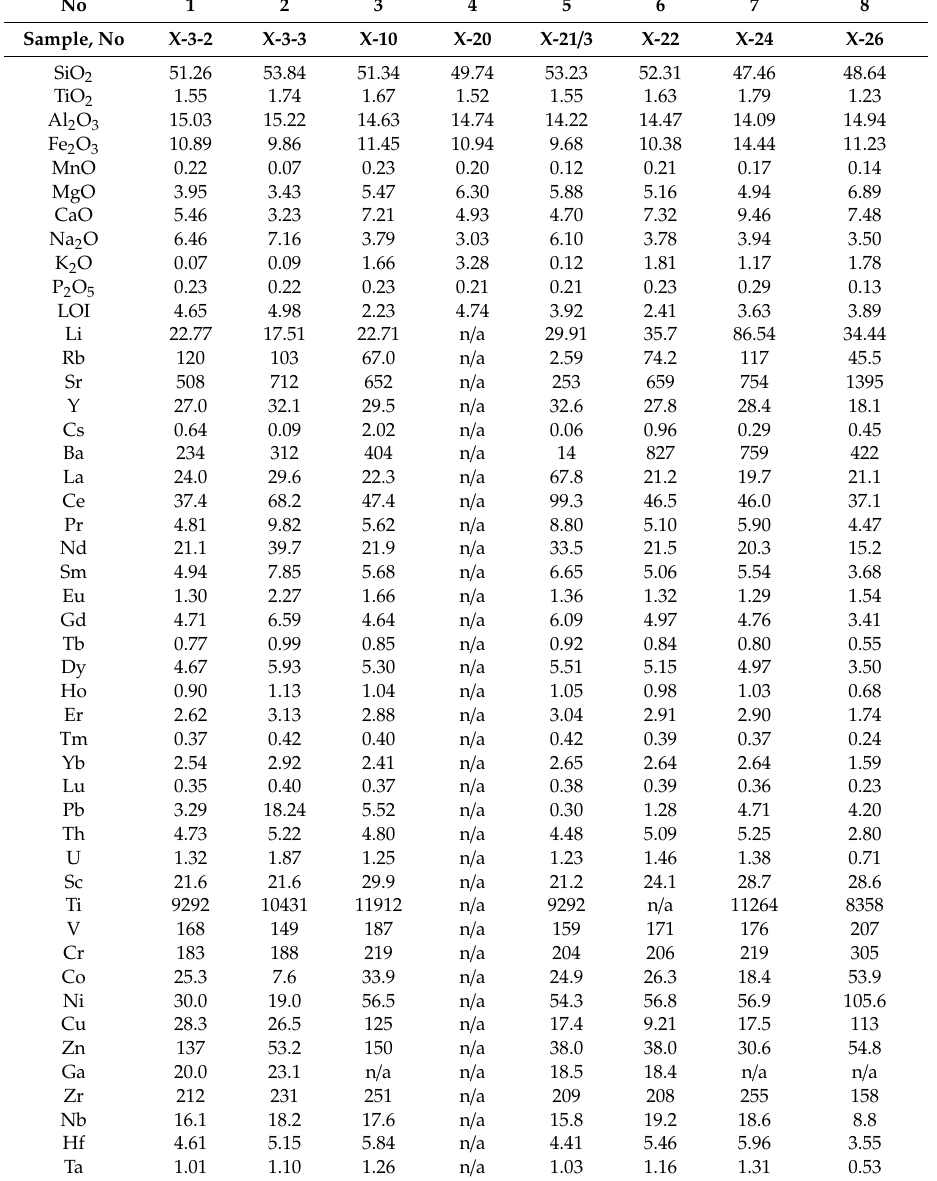
Table 2. Composition of the volcanic rocks from the Khalil and Kaya sites and Norilsk area.